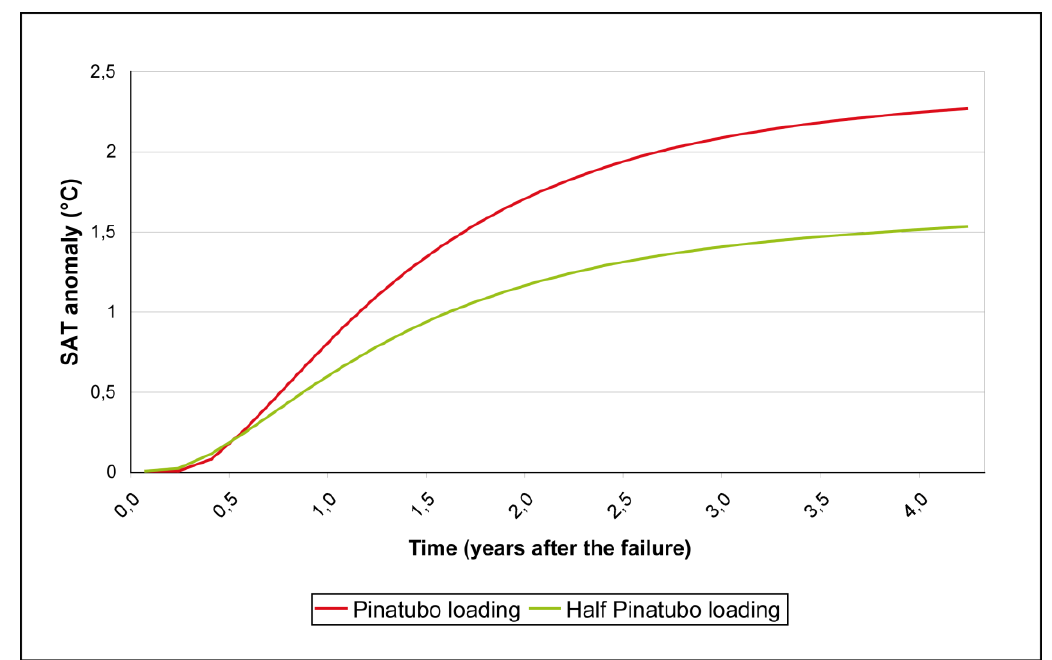
Figure 7 . Globally averaged SAT warming after a geoengineering failure at 2050 with different aerosol